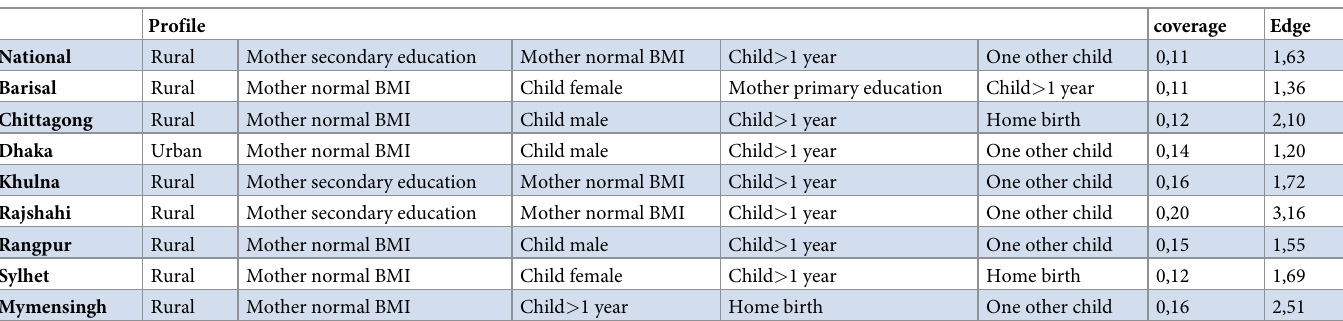
Table 3. Polling results from 2017/18 BDHS (new